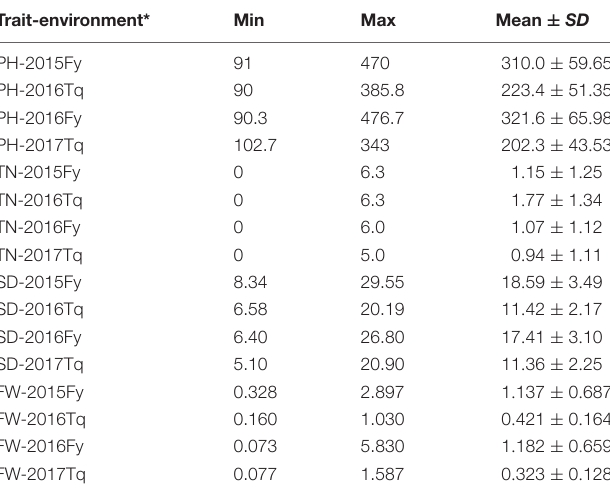
TABLE 1 | Statistical descriptions of four yield-related traits in the 245 sorghum accessions evaluated in four environments.